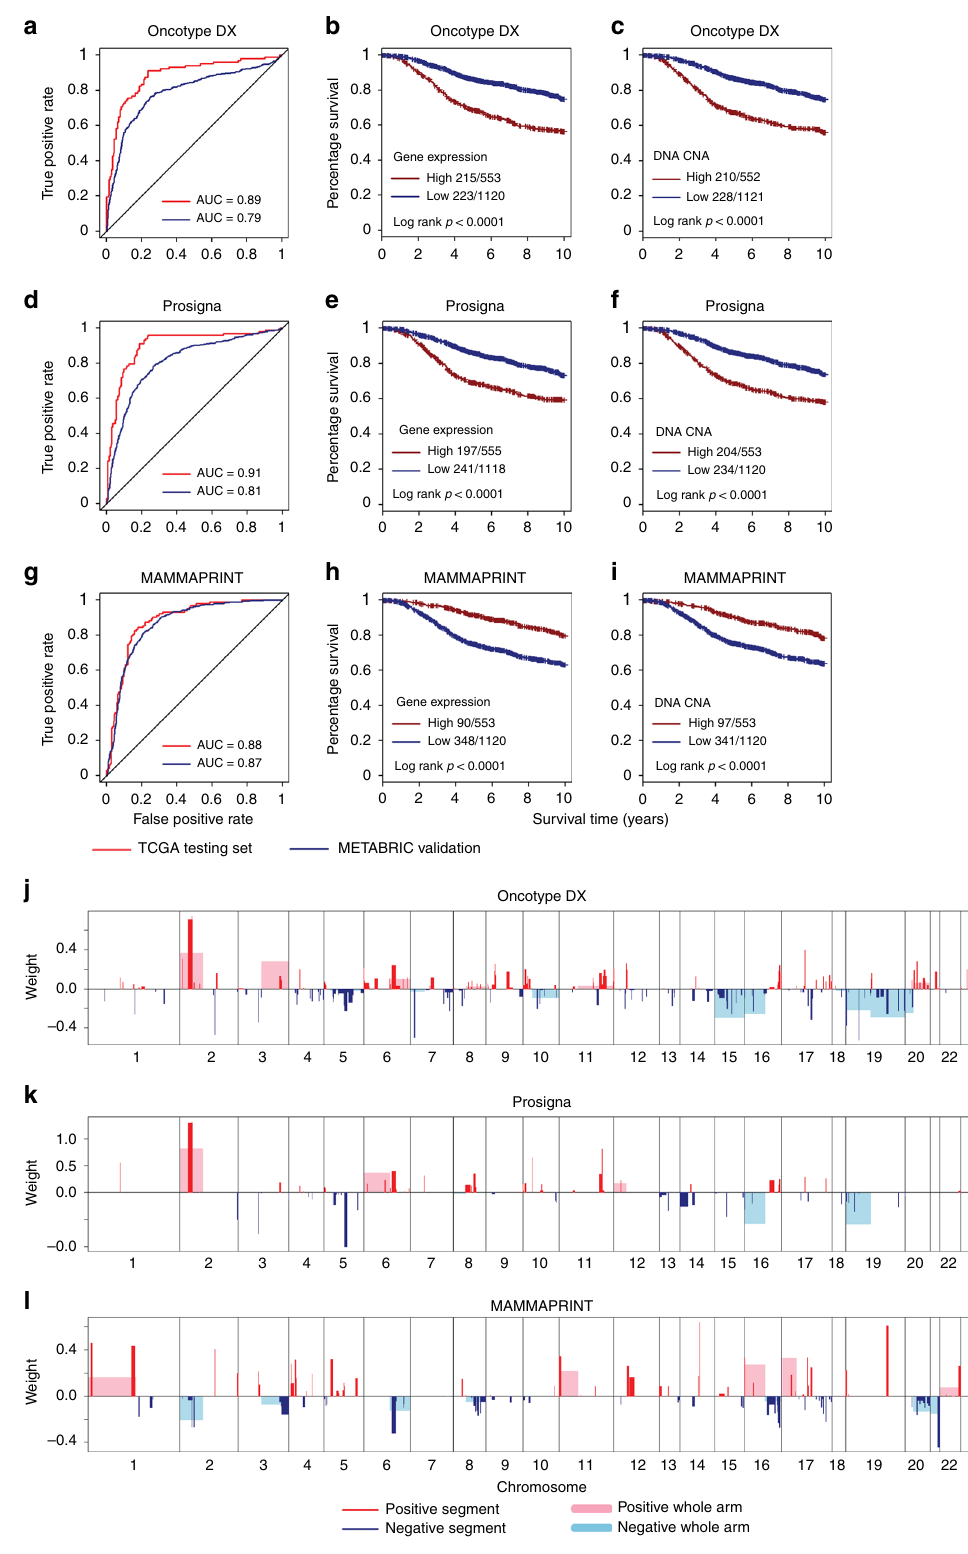
Fig. 3 CNA-based Elastic Net prediction models for three clinically used breast cancer assays. a – i ROC curves and Kaplan – Meier curves of 10-year breast cancer-speci fi c survival for Oncotype DX recurrence score ( a – c ), Prosigna risk of recurrence score ( d – f ) and MAMMAPRINT 70-GENE recurrence score ( g – i ) Kaplan – Meier curves were strati fi ed by gene signature score (Gene Expression) and corresponding Elastic Net copy number prediction model (DNA CNA). Event statistics were indicated as number of events/total patients in both High and Low groups. j – l Elastic Net selected CNA segments and/ or whole chromosomal arms and their coef fi cients for prediction models for Oncotype DX recurrence score ( j ), Prosigna risk of recurrence score ( k ) and MAMMAPRINT 70-GENE recurrence score ( l